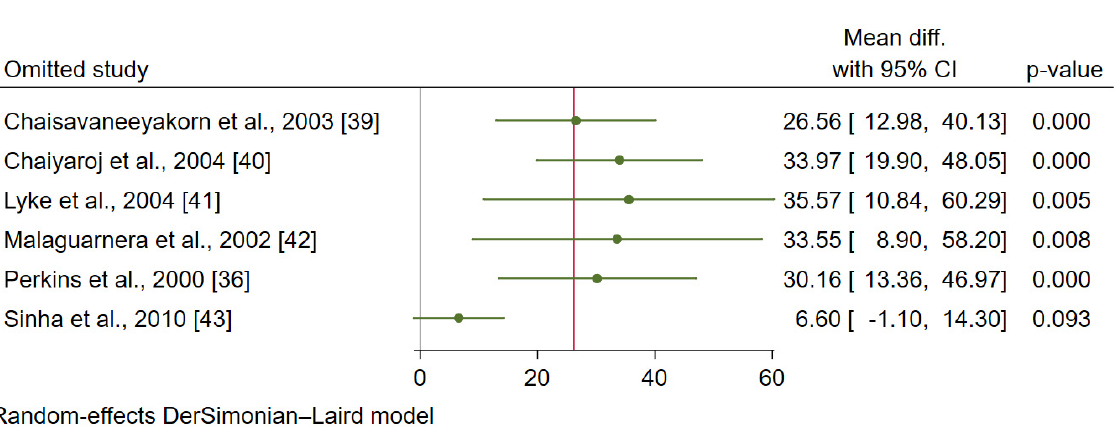
Figure 8. The results of the leave-one-out meta-analysis of the difference in the mean IL-12 levels (pg/mL) between patients with severe malaria and uncomplicated malaria [35–44].